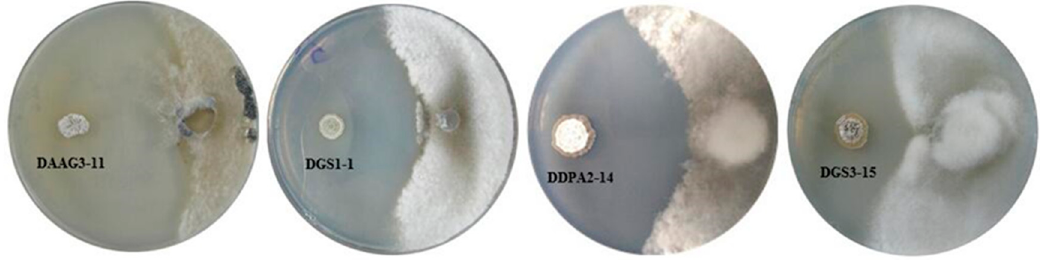
Figure 2. Dual culture plate assay between four endophytic actinobacteria against S. sclerotiorum . Table 1. Antagonistic potential endophytic actinobacteria isolated from healthy and diseased soybean root, and similarity values for 16S rRNA gene sequences. Isolate No. and NCBI Genbank Accesion No.